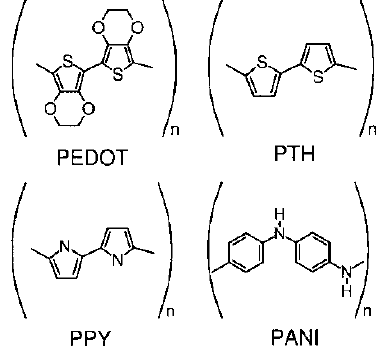
FIGURE 1 Chemical structure of some selected conductive polymers: PEDOT (poly(3,4- ethylene dioxythiophene)), PTH (polythiophene), PPY (polypyrrole) and PANI